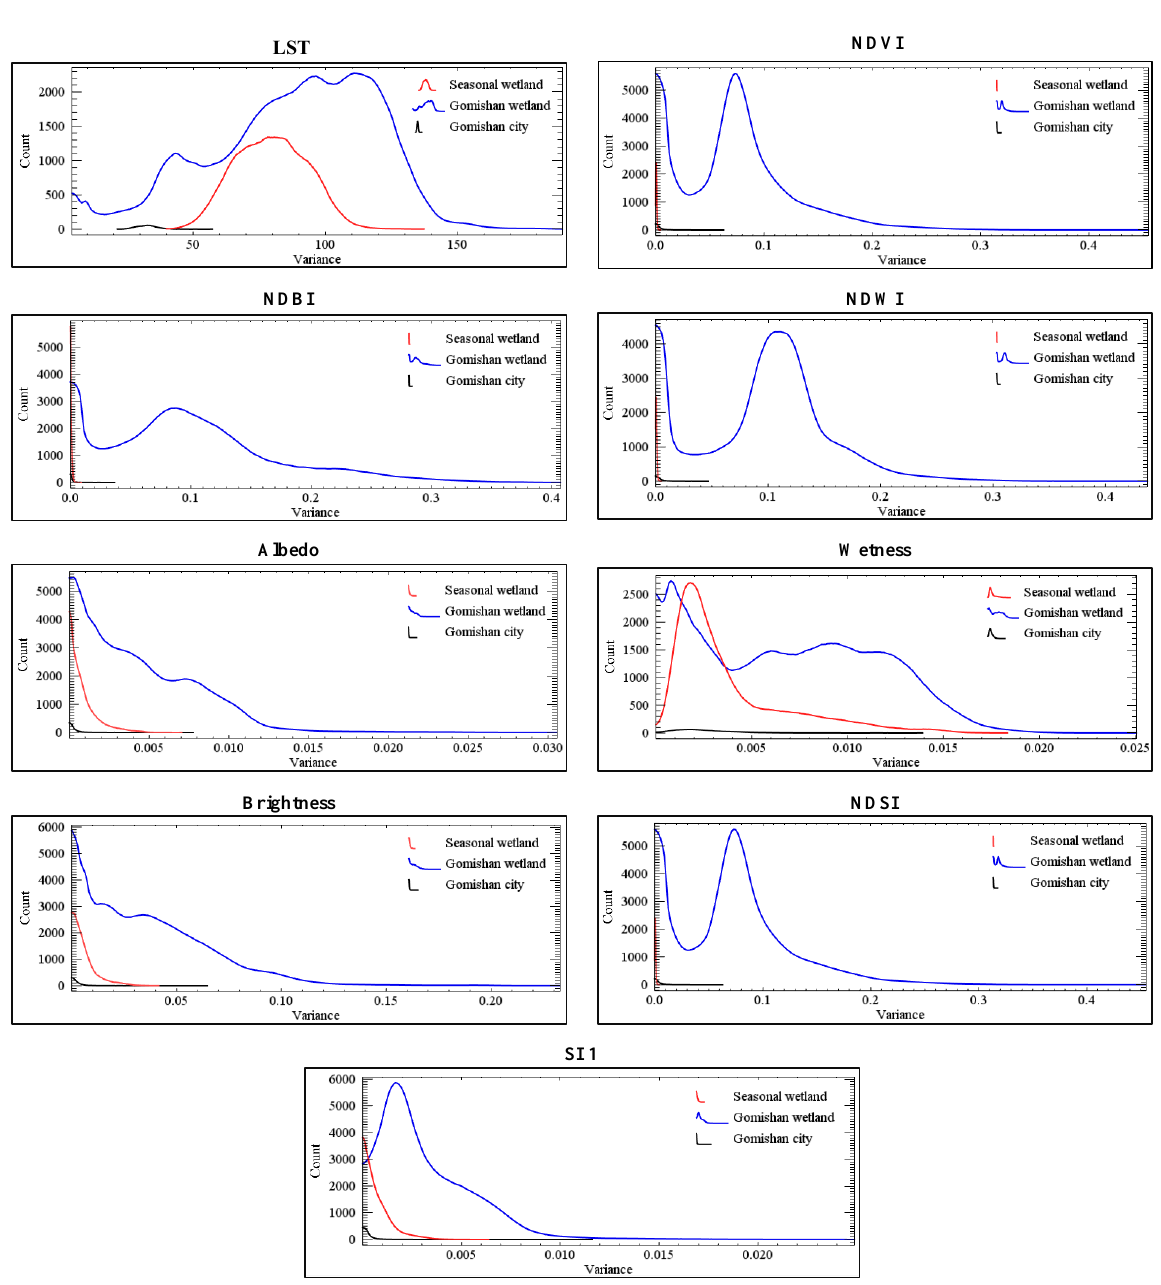
Figure 3. Histogram of variance values of biophysical properties of Gemishan city and wetland, and seasonal wetland The average of surface biophysical characteristics variance of the area was calculated and shown in Figure Gomishan city and wetland, seasonal wetland, and study